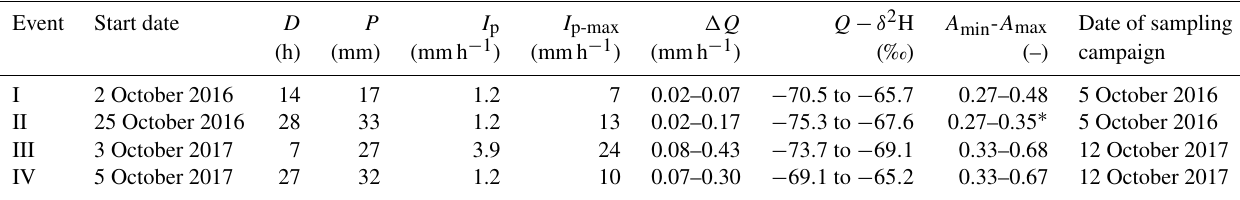
Table 1. Overview of the four events analysed in this study: event duration ( D , h), rainfall amount ( P , mm), average and maximum 10min rainfall intensity ( I p and I p-max , mmh − 1 ), the maximum change in specific discharge ( (cid:49)Q , mmh − 1 ), the maximum change in isotopic composition of the stream water ( δ 2 H, ‰), the minimum and maximum fraction of the catchment that was connected ( A min - A max ) during the event, and the date of the groundwater and soil water sampling